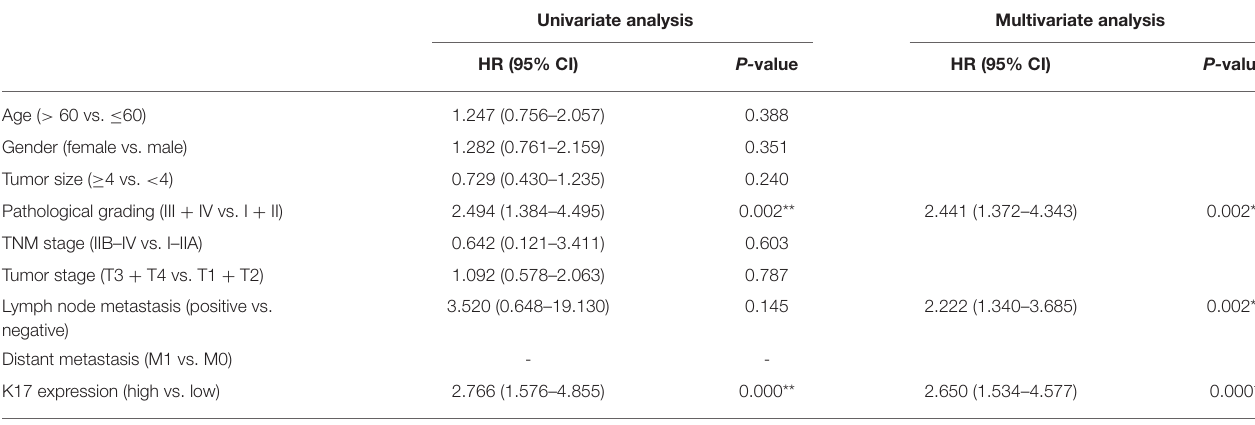
TABLE 2 | Cox proportional hazard models for prognostic